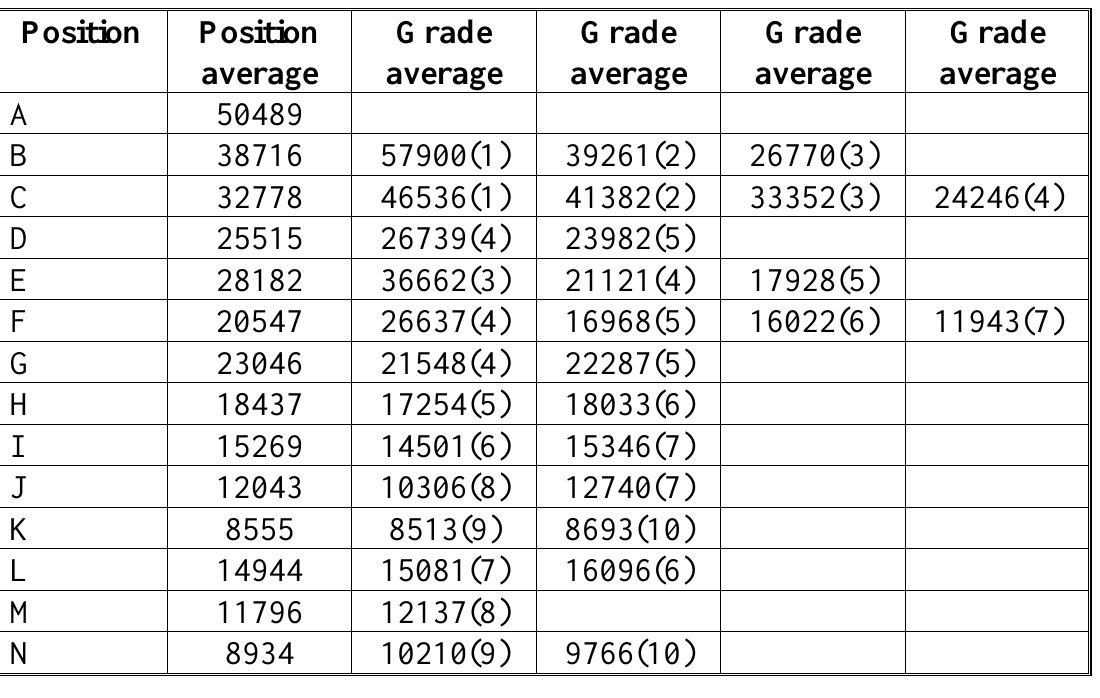
Organization weighted averages per position: